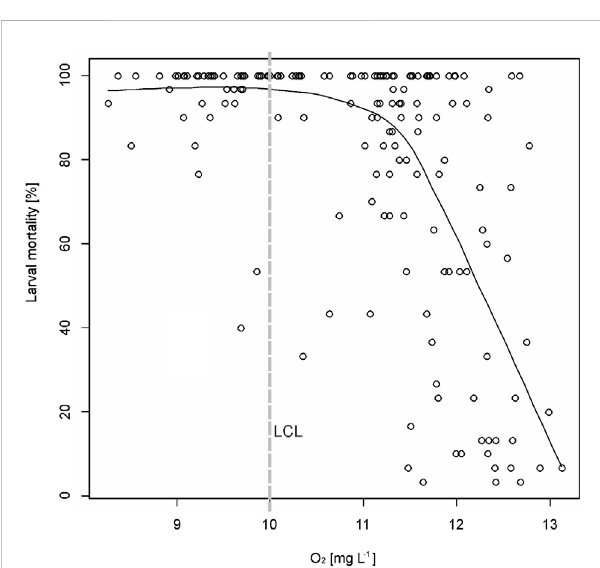
FIGURE 6 Correlation plot of the oxygen concentration measured in the HESTsagainstlarvalmortality.Thesmoothcurvesarelocallyweighted regression fi ts (Cleveland and Devlin, 1988) to the data points. LCL, lower critical limit for egg to fry survival according to Smialek et al.